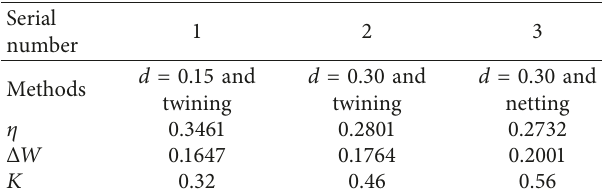
Table 4: Loss factor, energy dissipation, and average dynamic stiffness.